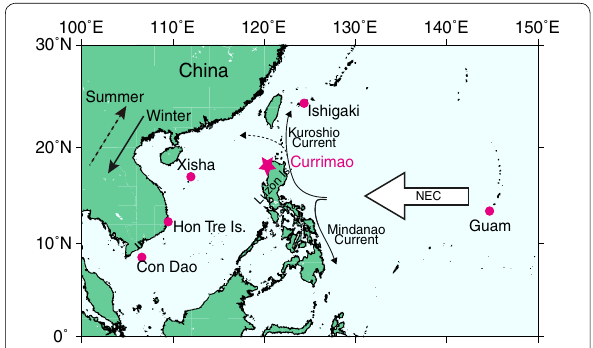
Fig. 1 Map of the South China Sea and coral sampling site ( star ). Black solid and dotted arrows indicate the wind directions of the East Asian monsoon during winter and summer,